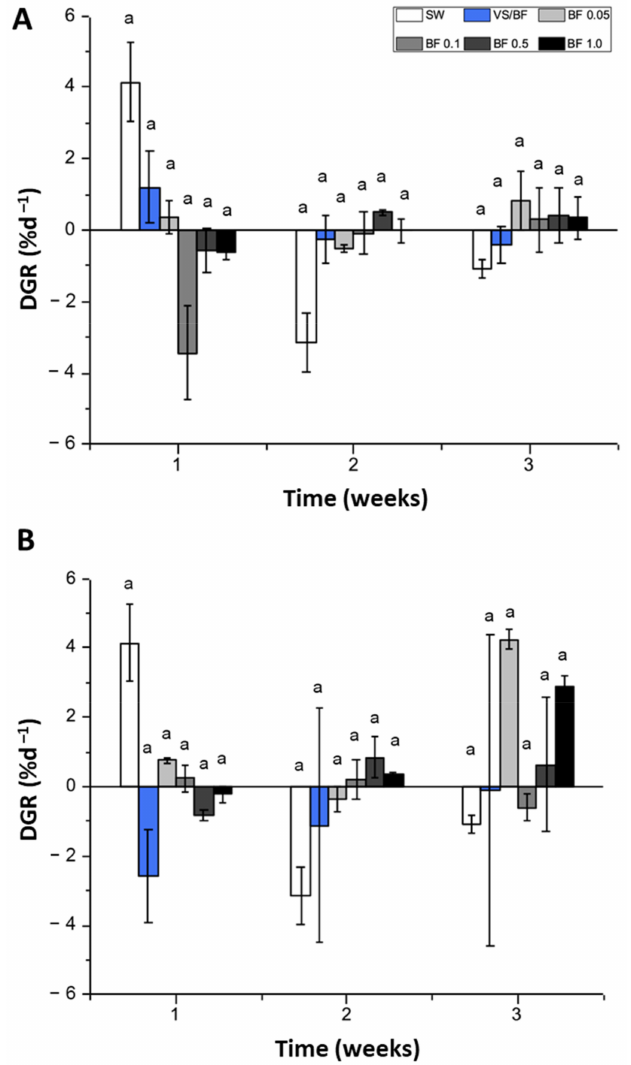
Figure 2. DGR (% d –1 ) of G. chilensis obtained under ( A ) indoor and ( B ) outdoor cultivation systems for each treatment evaluated (seawater (SW) treatment or control, Von Stosch/Basfoliar ® Aktiv (VS/BF), and Basfoliar ® Aktiv (0.05%, 0.1%, 0.5%, and 1% v / v ) treatments) during the three weeks of the experimental period. Values are the mean ± SD of three replicates. The letters above the bar plots indicate the results of Dunn ´ s tests; means with the same letter are not significantly different at p ≥